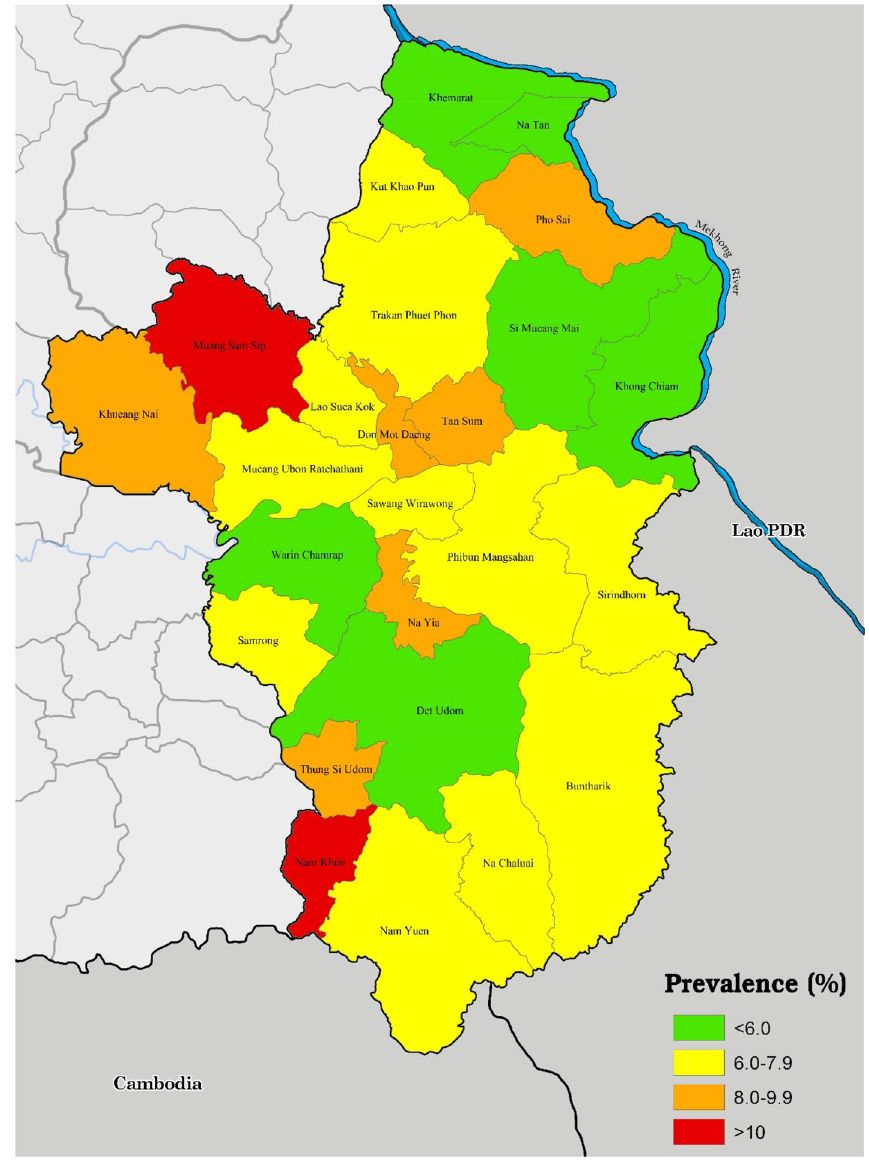
Figure 1. Prevalence of skin diseases across different districts of Ubonratchathani. This map was generated using QGIS version